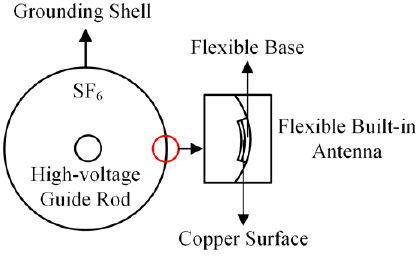
Figure 13. GIS built-in simplified model.